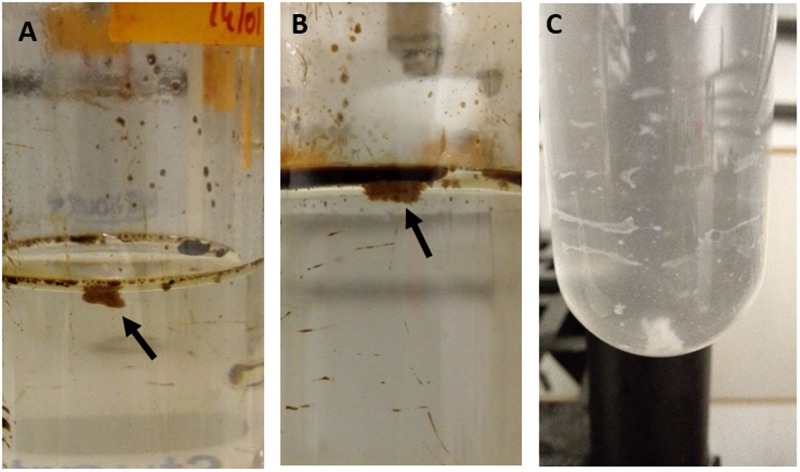
Marine oil snow aggregates shown floating at the surface of the CEWAF (A) and CEWAF+N (B) roller-bottle incubations, and Marine Dispersant Snow (MDS) aggregates shown settled at the bottom of the bottles in the SW+D treatments (C).